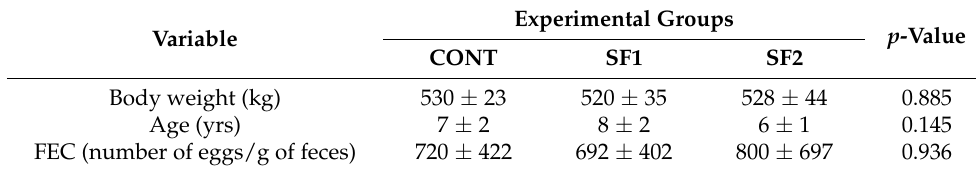
Table 1. Means ± SD of body weight, age and FEC at Day 0 for the three experimental groups. The p -values of one-way ANOVA testing if these initial values differed among groups were also reported.